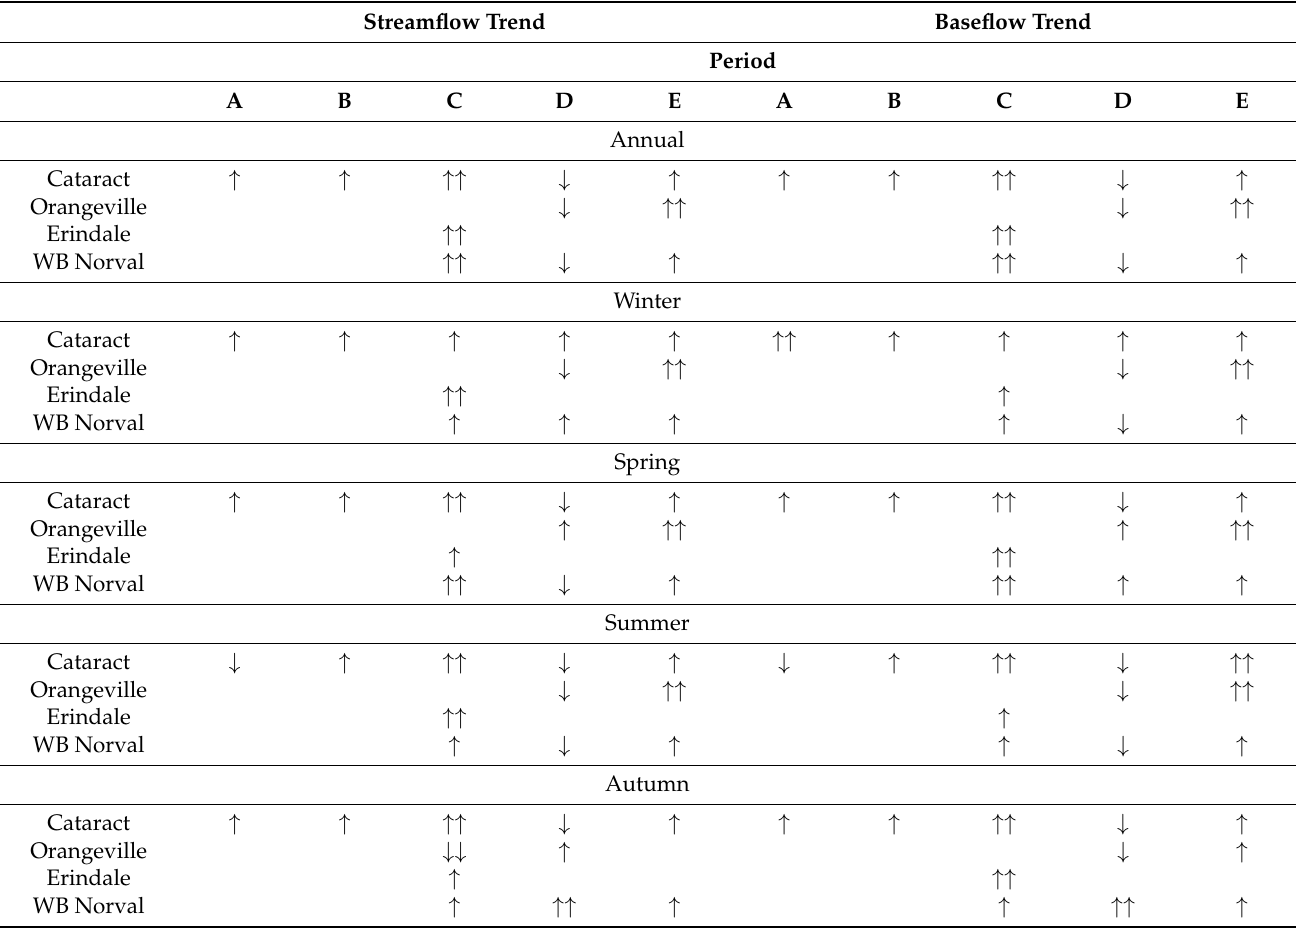
Table 5. Significant (up/down arrow) and non-significant (horizontal arrow) temporal trends in the